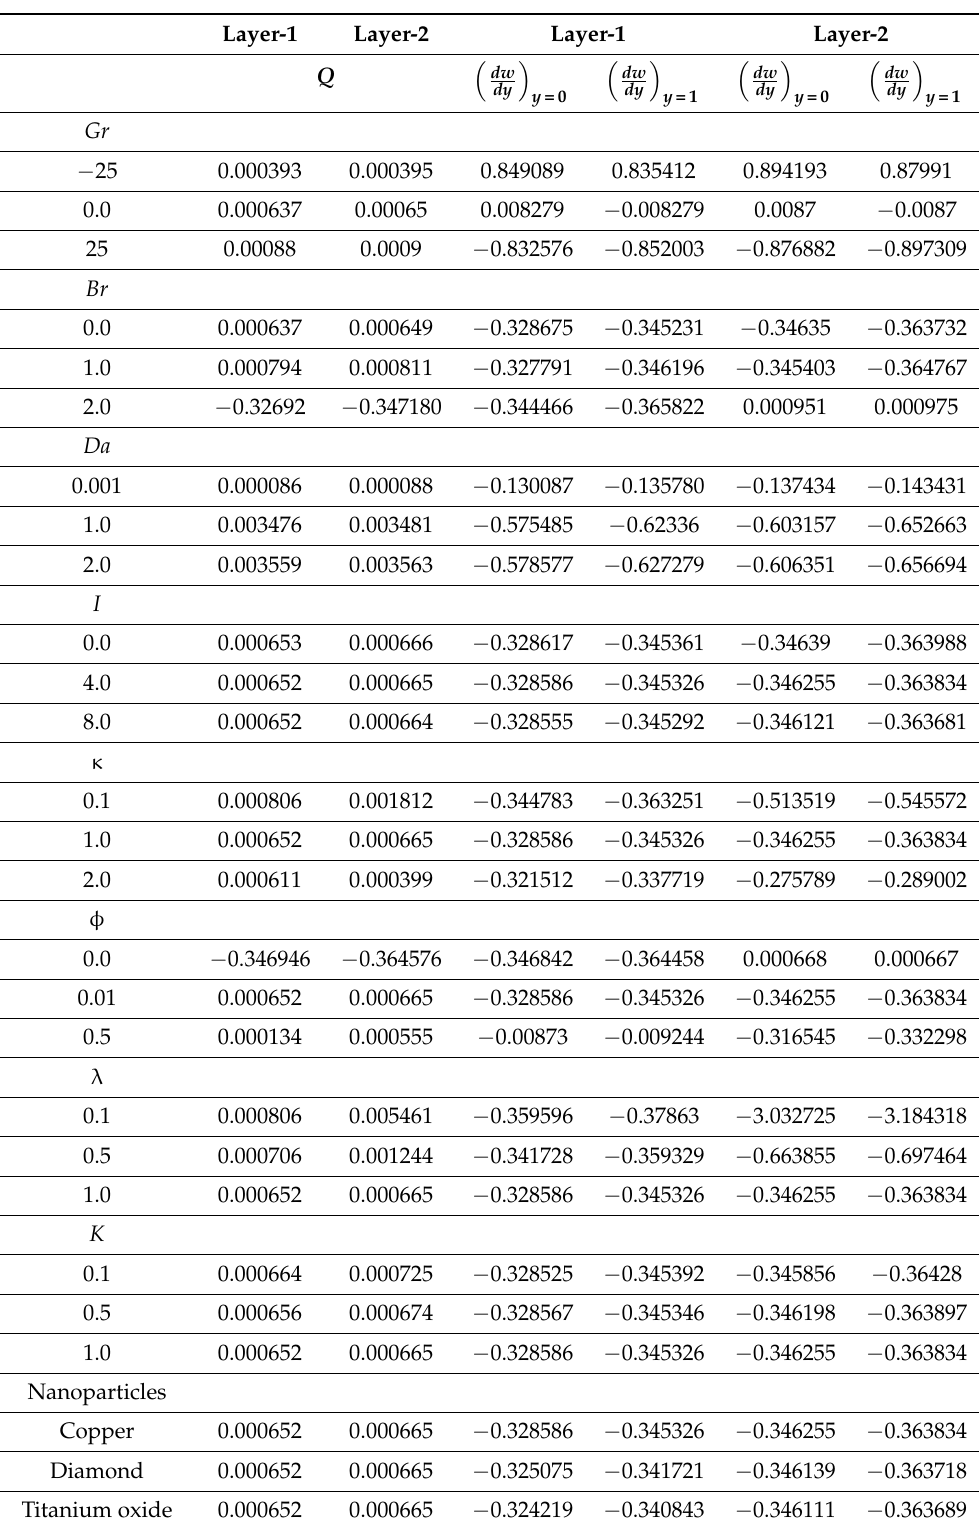
Table 4. Volumetric flow rate and skin